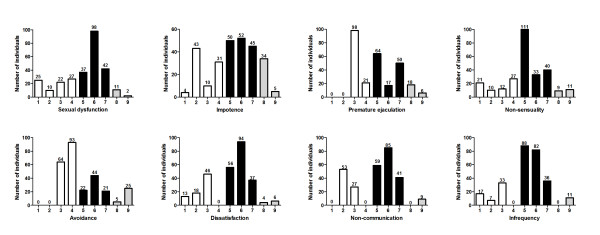
Scores of sexual dysfunction in 292 studied population according to GRISS questionnaire. Graph shows the distribution of scores (from 1 to 9 on the x- axis) for each GRISS subscale, with the number of patients (y-axis) above each score. Normal scores are 1 to 4 (clear columns), abnormal scores are 5 to 9 (shaded columns) and severe abnormal scores are 8 and 9 (grey columns).